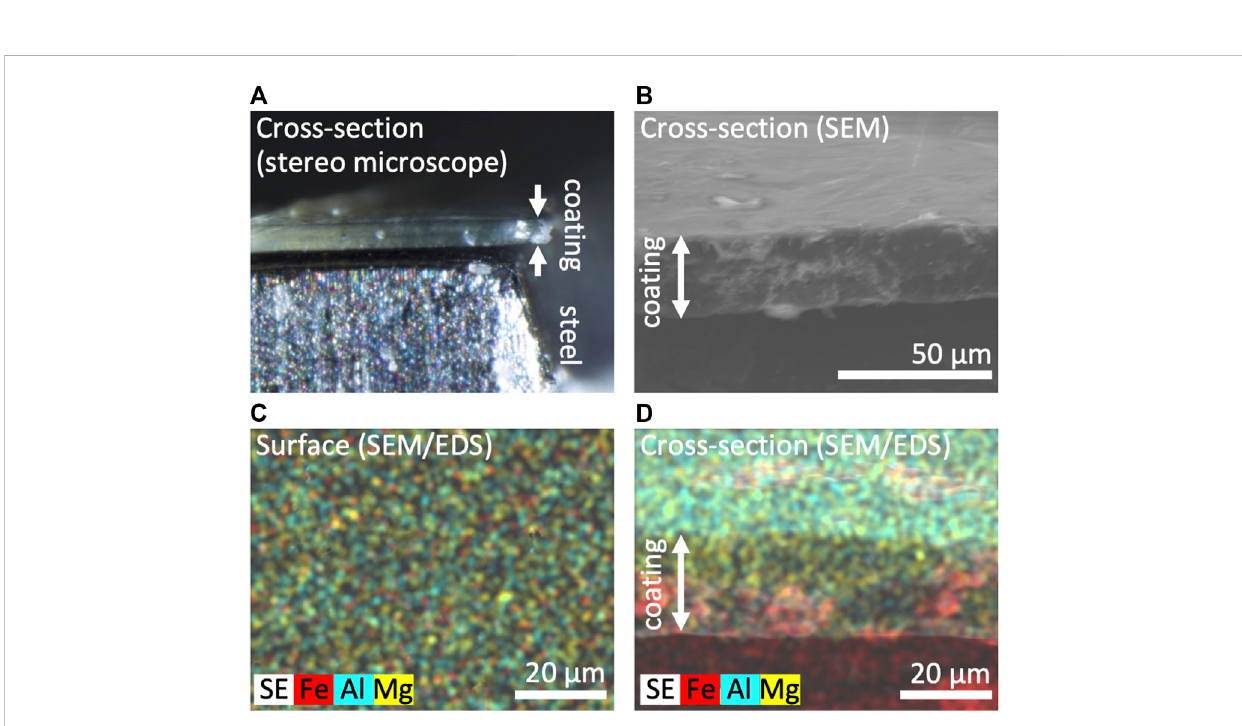
FIGURE 7 Analysis of the cross-section (A, B, D) and surface (C) of the acrylic polyurethane AQ CC 80 coating with 10 wt% Mg-Al/[Fe(CN) 6 ] LDH sensing nanoadditive by stereo microscope (A) and SEM (B) and SEM/EDS mapping (C, D) .